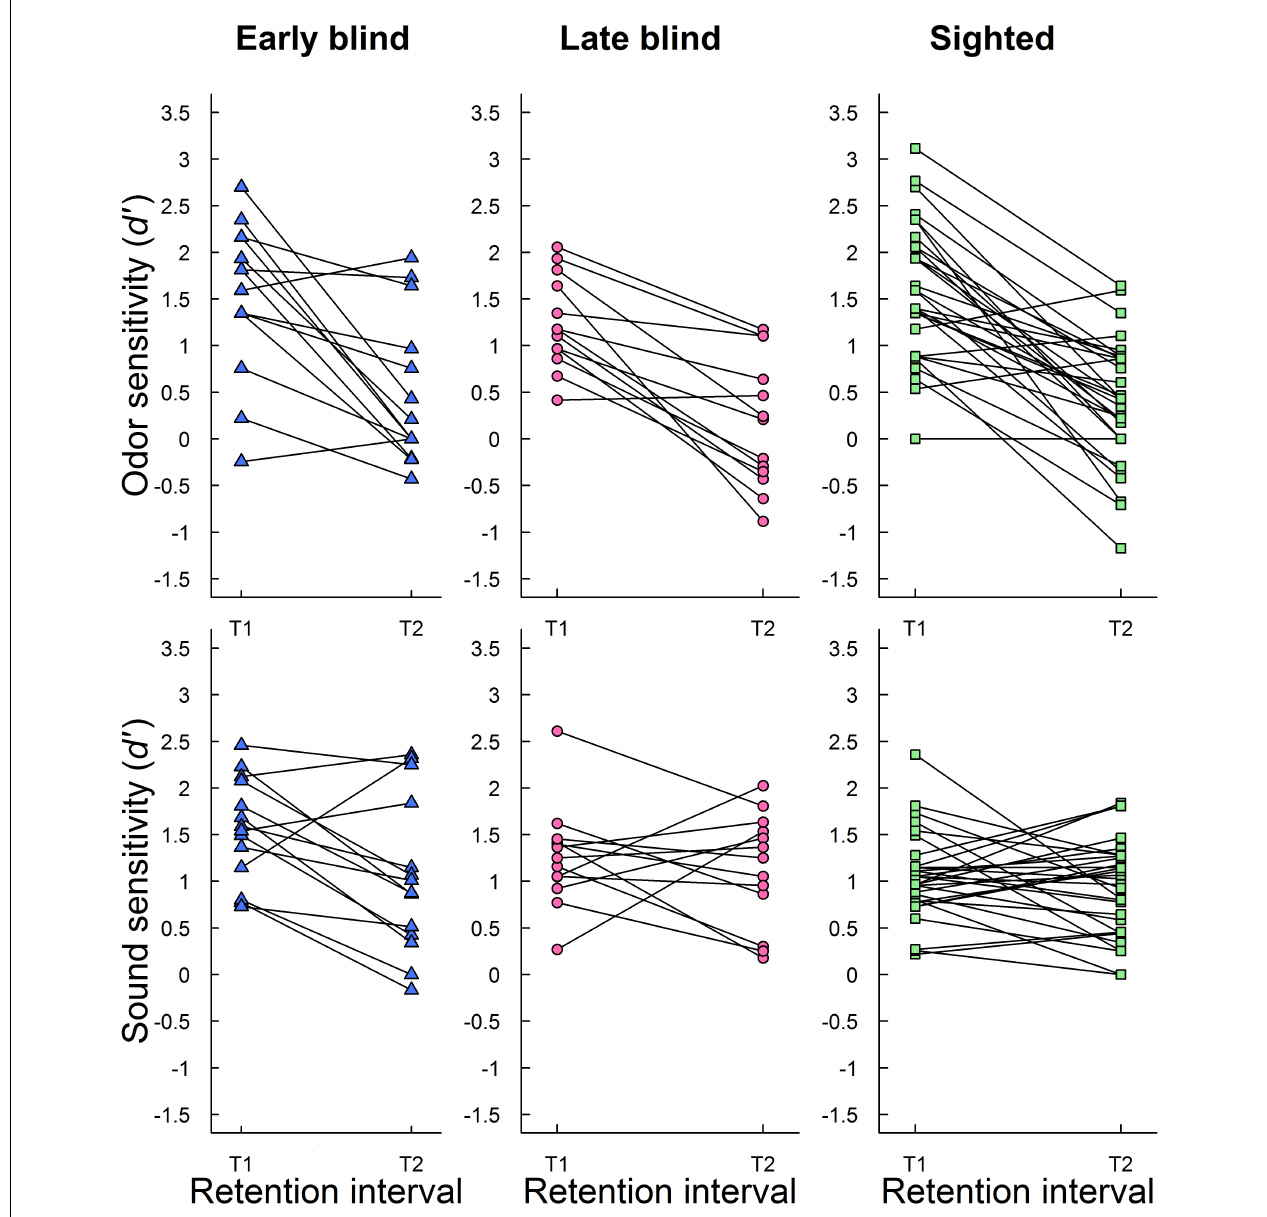
FIGURE 2 | Individual episodic recognition performance ( d (cid:48) ) for odors (upper panel) and sounds (lower panel) at initial testing (T1) and follow-up (T2) is plotted separately for early blind, late blind, and sighted participants.